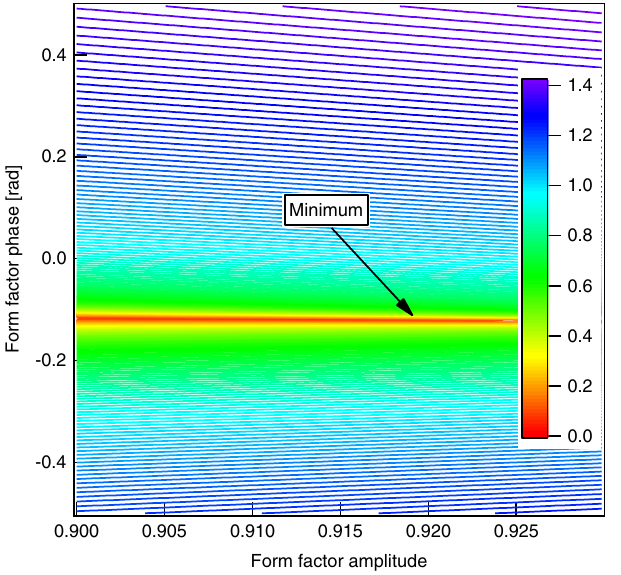
FIG. 14. Contour plot of the penalty function g for 4 . 4 M Ω and Δ f ¼ − 60 . 36 kHz. The origin of the phase R s ¼ coordinate is chosen such that V